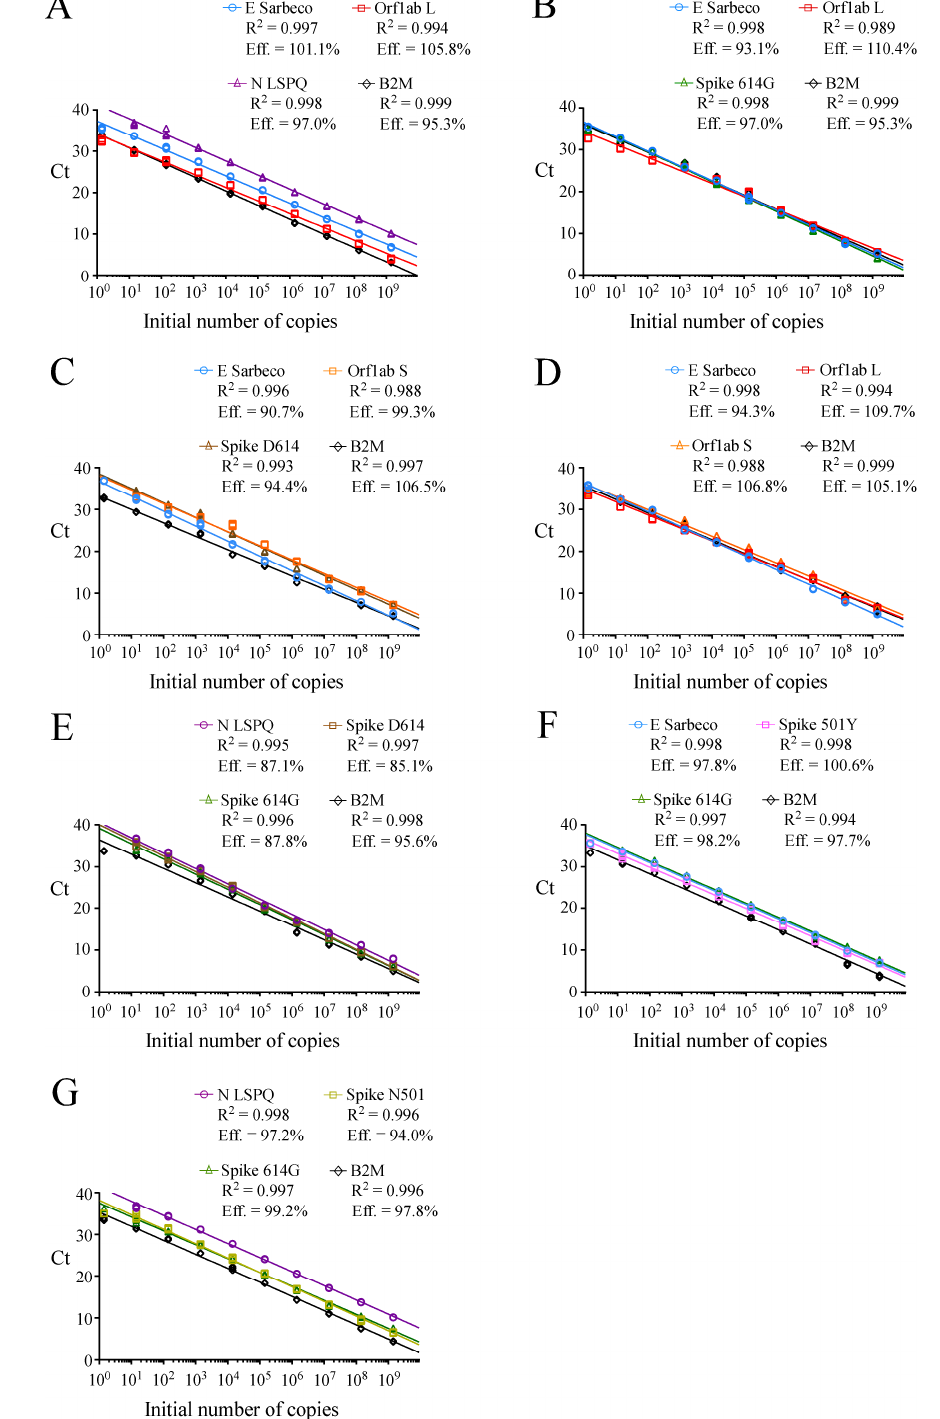
FIGURE 2: Linear regression curves to assess synthetic RNA copy number in fourplex rRT-PCR assays. (A–G) For each repre- sentative graph, four primer- probe sets within one reaction mixture were used to detect serial 10-fold dilutions of four synthetic RNA transcripts ranging from 10 0 to 10 9 copies per reaction. The y and x axes of each graph are the C t values and the log of the input of synthetic RNA transcripts. respec- tively. For each fourplex reaction, R 2 indicates calculated linear coef- ficients and Eff. shows percentage of amplification efficiencies for each primer-probe set that is present with three other sets of primers and probes within one reaction master mixture. Fluoro- genic probe color codes are as follows: blue, E Sarbeco; red, Orf1ab L; violet, N LSPQ; black, B2M; green, Spike 614G; orange, Orf1ab S; brown, Spike D614; pink, Spike 501Y; and gold, Spike N501. The graphs represent quantifica- tion of the results of three inde- pendent